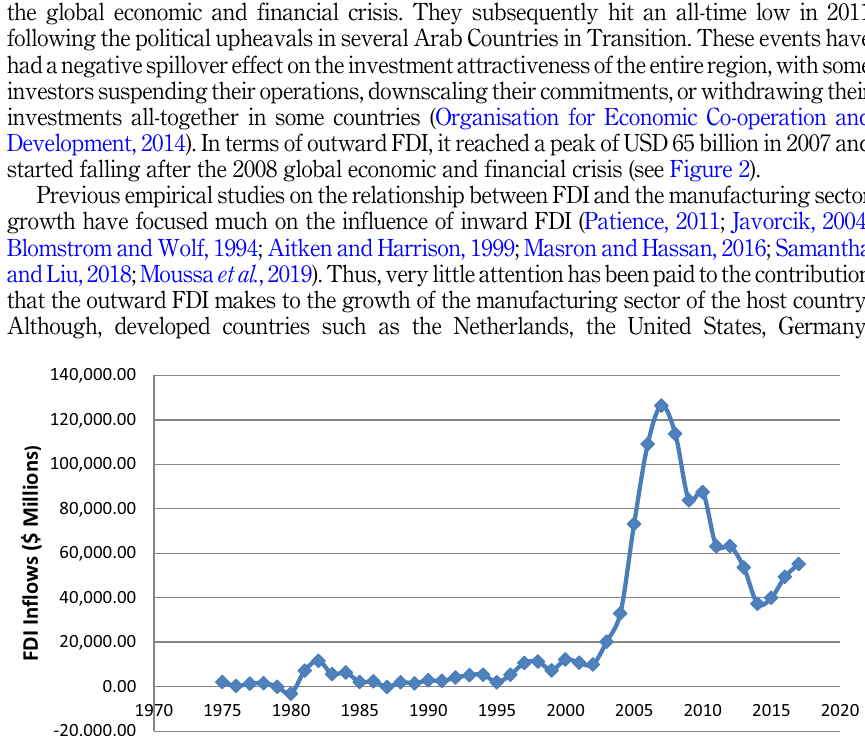
Figure 1. Foreign direct investment inflows in the MENA